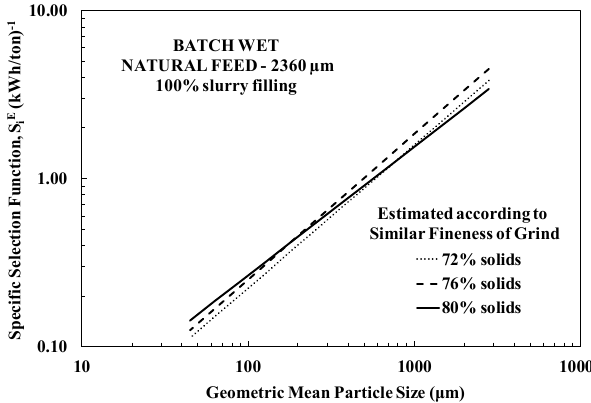
Figure 7. Specific selection functions estimated according to similar fineness of grind considering the influence of percent solids for a slurry filling of 100% for the batch grinding mill.